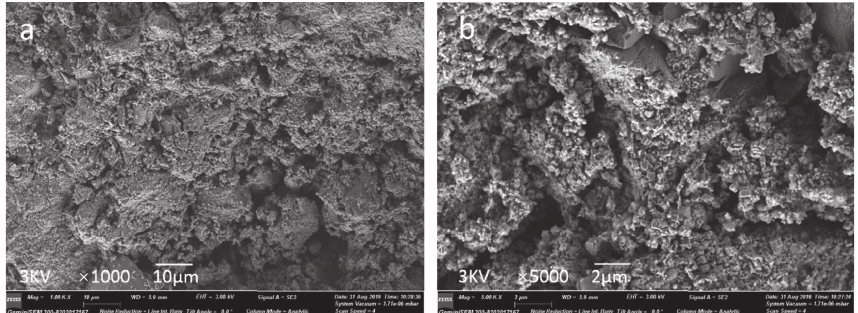
Figure 4: SEM micrographs showing the morphology of specimen b0 at 1000x (a) and 5000x (b) magnification.